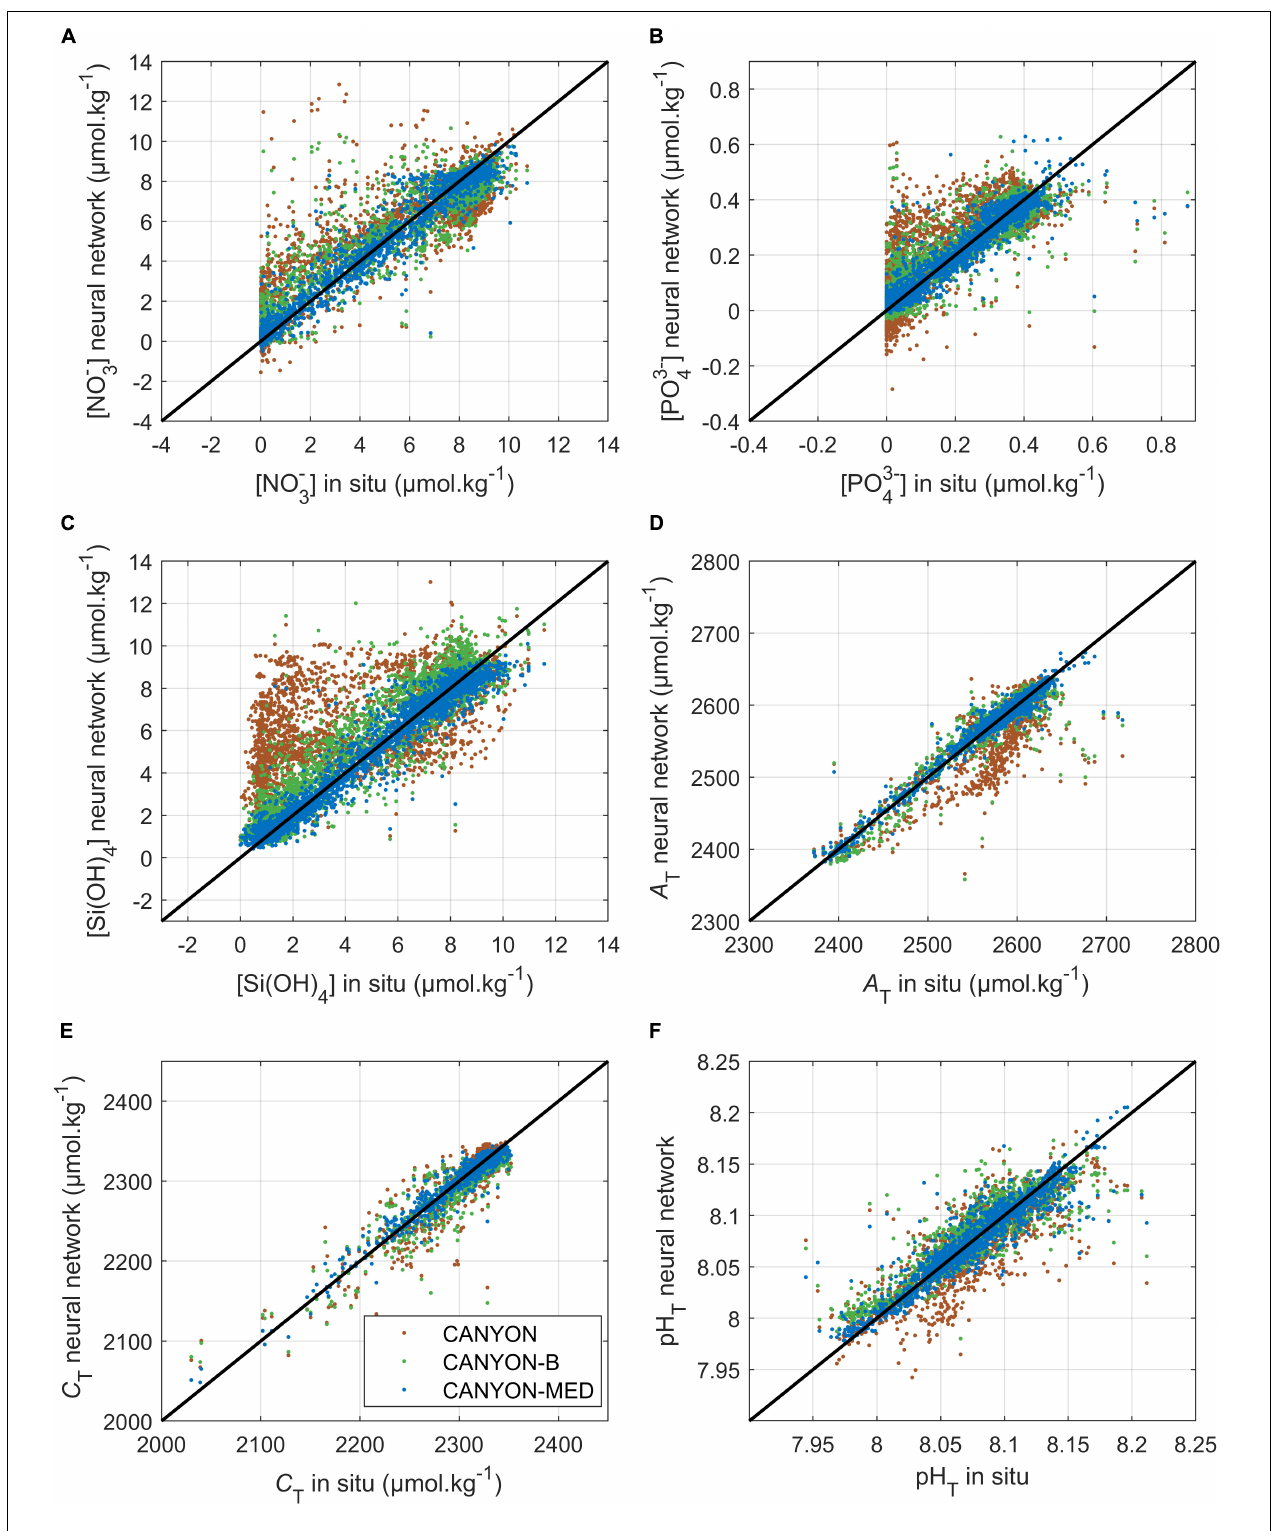
FIGURE 6 | Comparison of the CANYON (brown dots), CANYON-B (green dots) and CANYON-MED (blue dots) -retrieved values with the corresponding in situ measurements for (A) NO